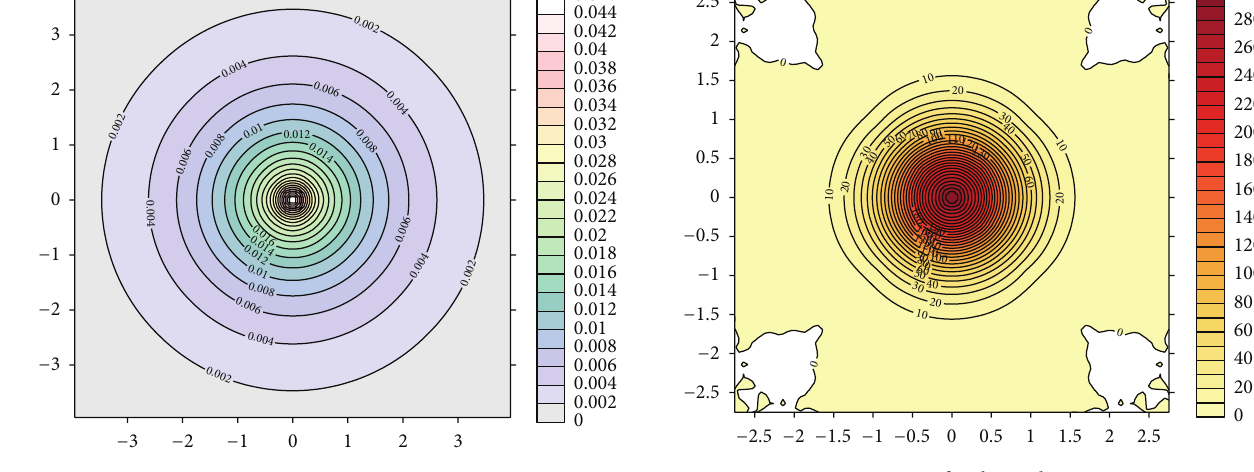
Figure 14: 3000 ∘ C thermal expansion contours.